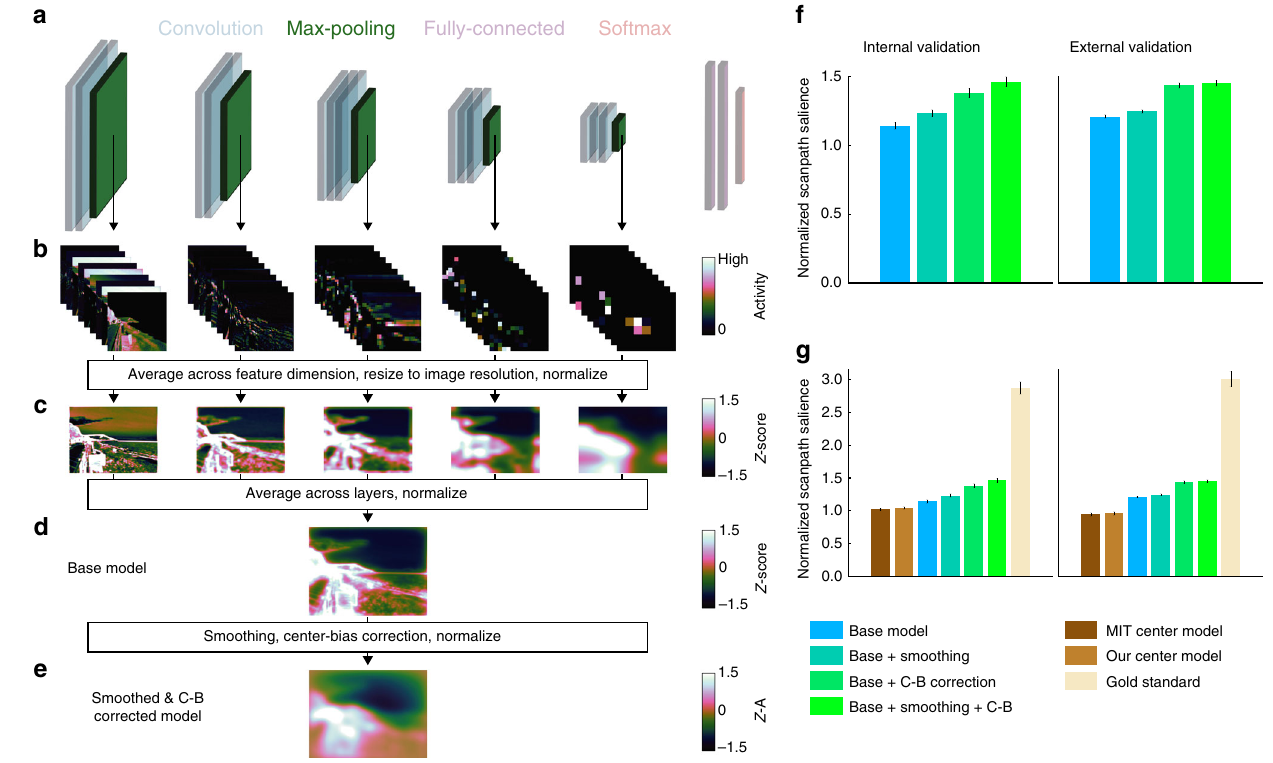
Fig. 3 Computational model of spatial attention. a A hierarchical CNN trained for scene categorization parametrized each image from pixel-space into a computational feature-space 10 – 12 . b Unit activity was extracted from the fi ve pooling layers to sample activity from across the CNN hierarchy. c We averaged across the channel dimension in each layer, resized the resultant activity map to the full image resolution (600 × 800 px), and normalized each map across spatial locations to have zero mean and unit standard deviation. This process produced a single activity map for each layer. d We averaged activity maps across layers and renormalized the resultant maps to get computational spatial priority maps for each image. This is the base version of our model. e To further boost predictions, we applied spatial smoothing and center-bias correction, then renormalized the resultant maps. This is the smoothed and center-bias corrected version of our model reported throughout the paper. f The computational spatial attention model predicts eye movement patterns. Spatial smoothing and center-bias correction both improve prediction performance, and the best performance is achieved when both additional operations are included. Equivalent results were found using the model to predict eye movements in our internal ( n = 11) and external ( n = 22) validation data sets. g Prediction performance for spatial attention model results and three benchmark models. The MIT Center Model was downloaded from the MIT Saliency Benchmark website (http://saliency.mit.edu/results_mit300.html). Our Center Model is de fi ned as a 2D Gaussian of 600× 600 px (SD = 600 px) linearly interpolated to the image resolution of 600× 800 px. The Gold Standard model is de fi ned as the group-average fi xation map for a given image in the opposite validation set. Group-average fi xation maps from the internal validation set were used to predict individual ’ s fi xations in the external validation set and vice versa. Error bars represent standard error of the mean across participants in the internal ( n = 11) or external ( n = 22 ) validation